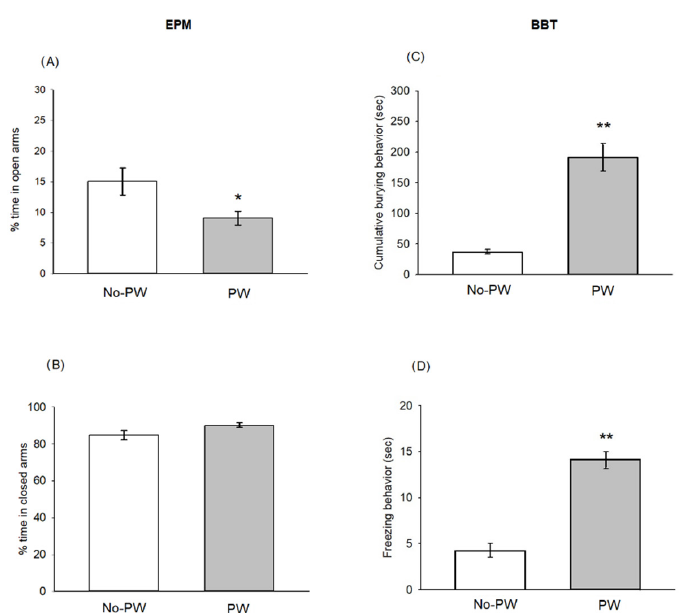
Figure 1. Left panels show the effects of progesterone withdrawal (PW) in Wistar Kyoto rats on the % of time spent in open arms ( A ), and the % of time spent in closed arms ( B ), in the elevated plus maze test (n = 6 per group). The right panels show the effects of PW on cumulative burying behavior ( C ), and freezing behavior ( D ), in the burying behavior test (n = 15 No-PW, n = 14 PW). Each bar represents the mean ± standard error of the mean. * p < 0.05, ** p < 0.01 vs. No ‐ PW group.